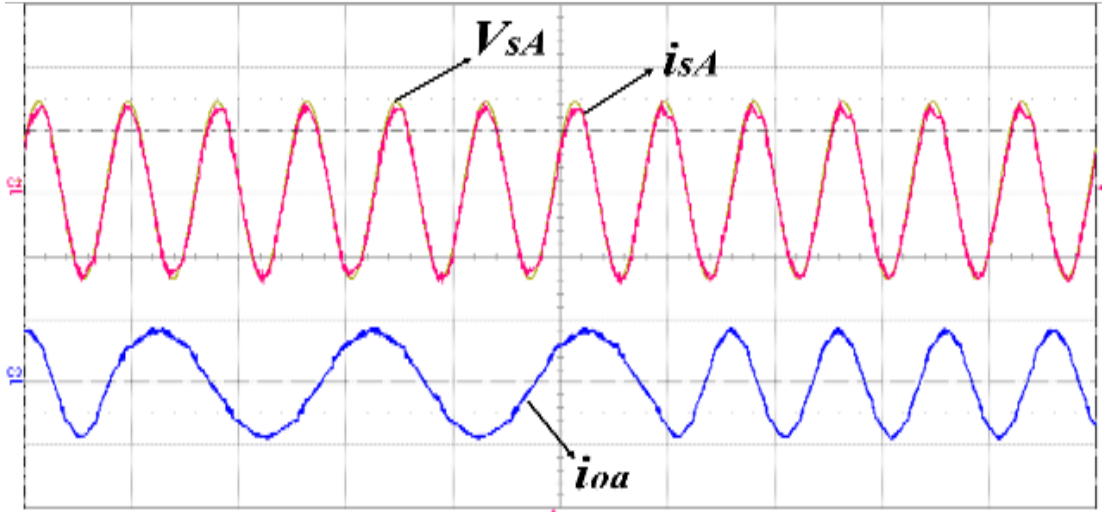
Figure 17. Experimental results of the proposed strategy with the IFRS, where output-current reference amplitude is set to 4.3 A and output-current frequency is changed from 25 Hz to 50 Hz, x-axis 20 ms/div. Waveforms of the source voltage V sA (100 V/div), source current i sA (2 A/div) and output current i oa (5 A/div).